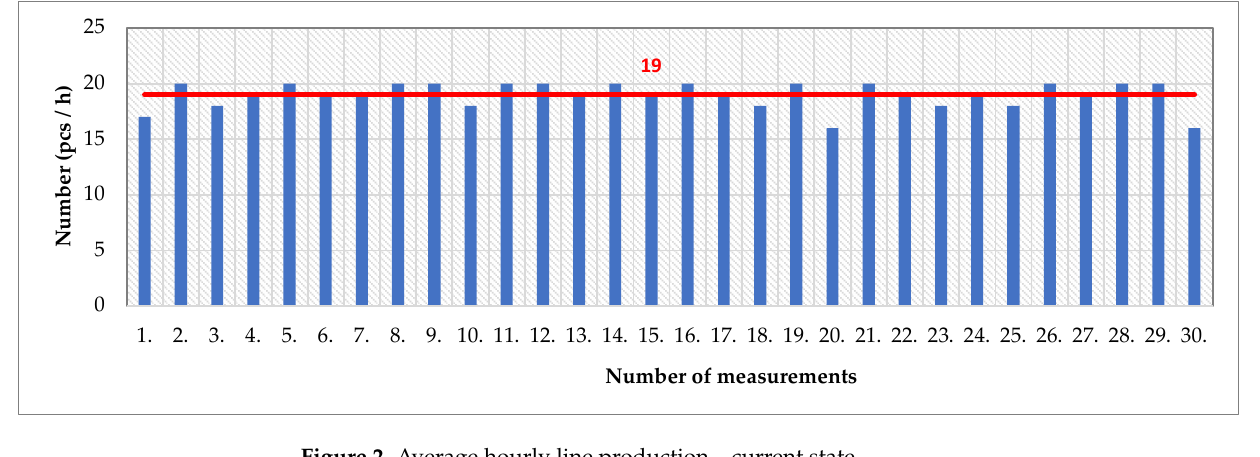
Figure 2. Average hourly line production—current state.